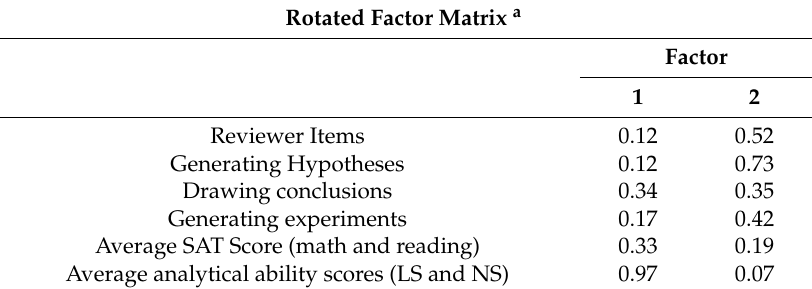
Table 19. Rotated factor matrix in the Study 2 maximum likelihood factor analysis of the total scores of all our subscales (including editor and reviewer items) and the analytical ability tests. Rotated Factor Matrix a Factor 1 2 Editor Items 0.36 0.30 Reviewer Items 0.11 0.58 Generating Hypotheses 0.11 0.62 Drawing conclusions 0.35 0.35 Generating experiments 0.23 0.45 Average SAT Score (math and reading) 0.35 0.15 Average analytical ability scores (LS and NS) 0.86 0.04